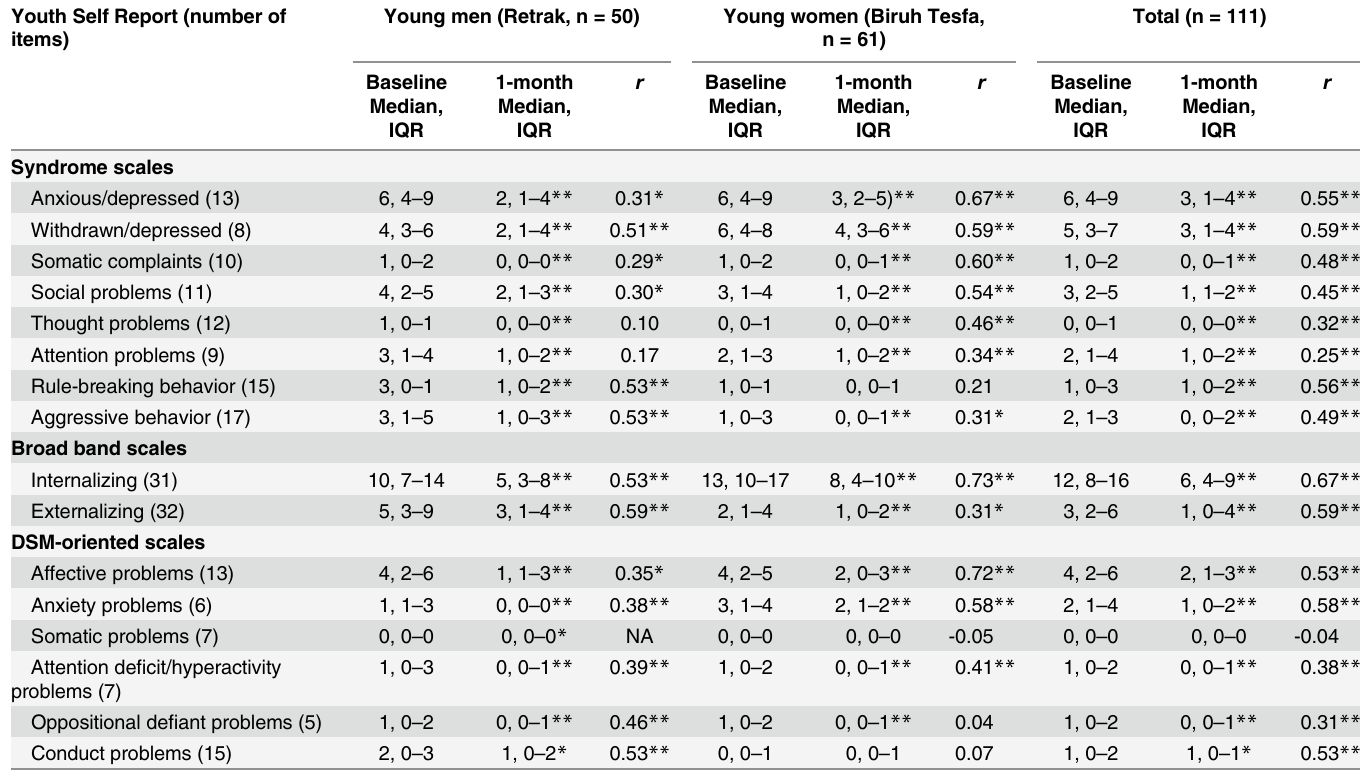
Table 3. Comparison and correlations of YSR scores between baseline and 1-month follow-up